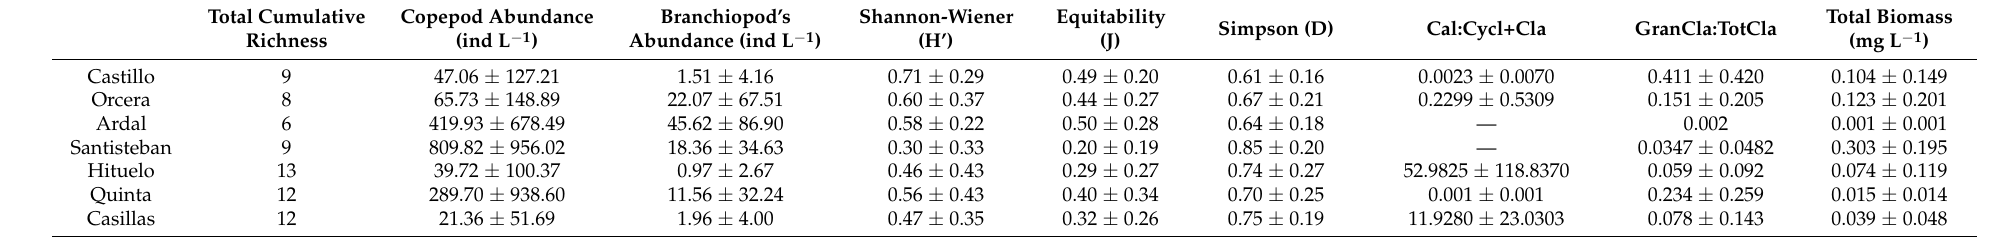
Table 2. Annual mean and standard deviation of zooplankton community parameters in the studied ponds.